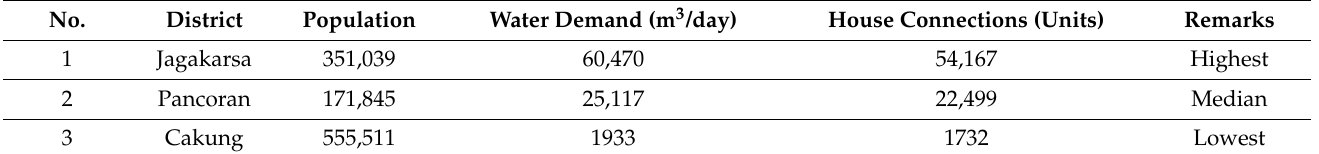
Table 3. Maximum, median, and minimum water